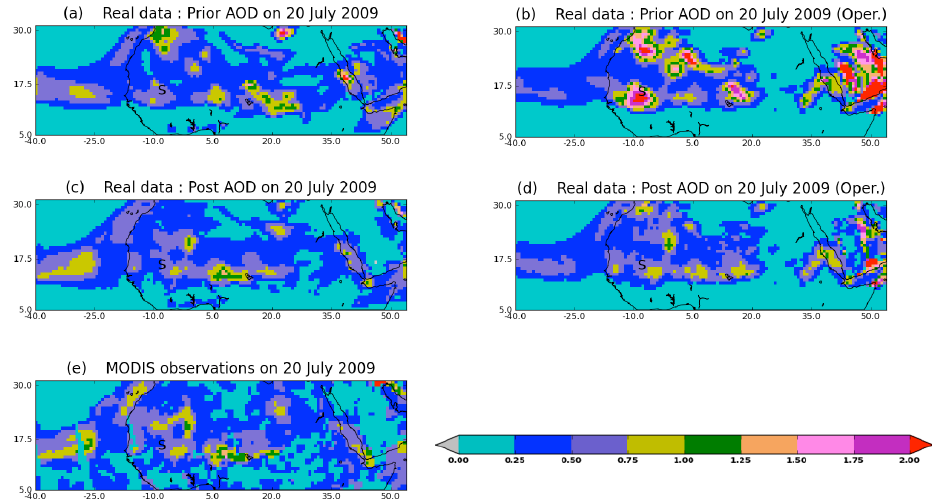
Fig. 10. Mean AOD estimates on 20 July 2009 at 12:00Z. (a) and (b) : priors using the tuned (Fig. 8c) and the operational maps (Fig. 1a), respectively. (c) and (d) : posteriors obtained by assimilating satellite data into the priors shown in (a) and (b) , respectively. (e) Satellite data. Figure 10 : Mean AOD estimates on 20 July 2009 at 12:00 Z. 8 July 2009 to 30 July 2009 (19 days) is used for